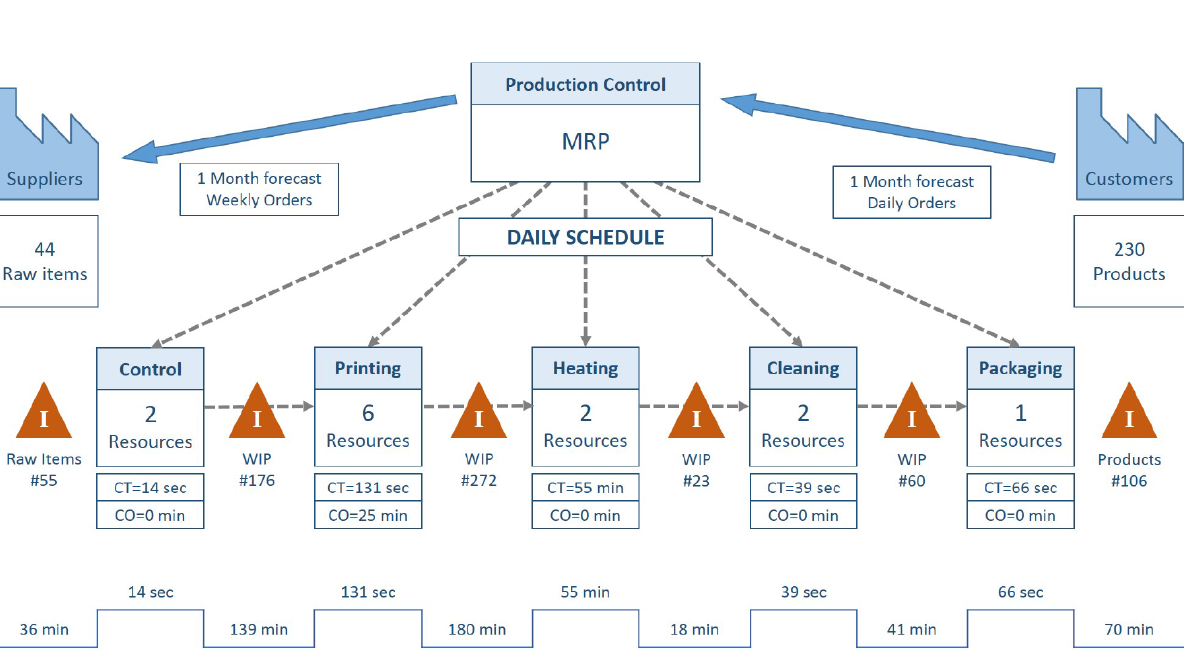
Figure 4. VSM Design Point: #2 SMED